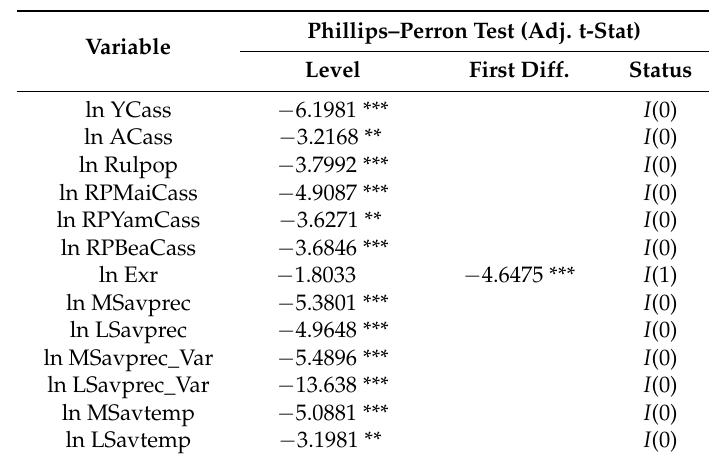
Table 1. Results of unit root